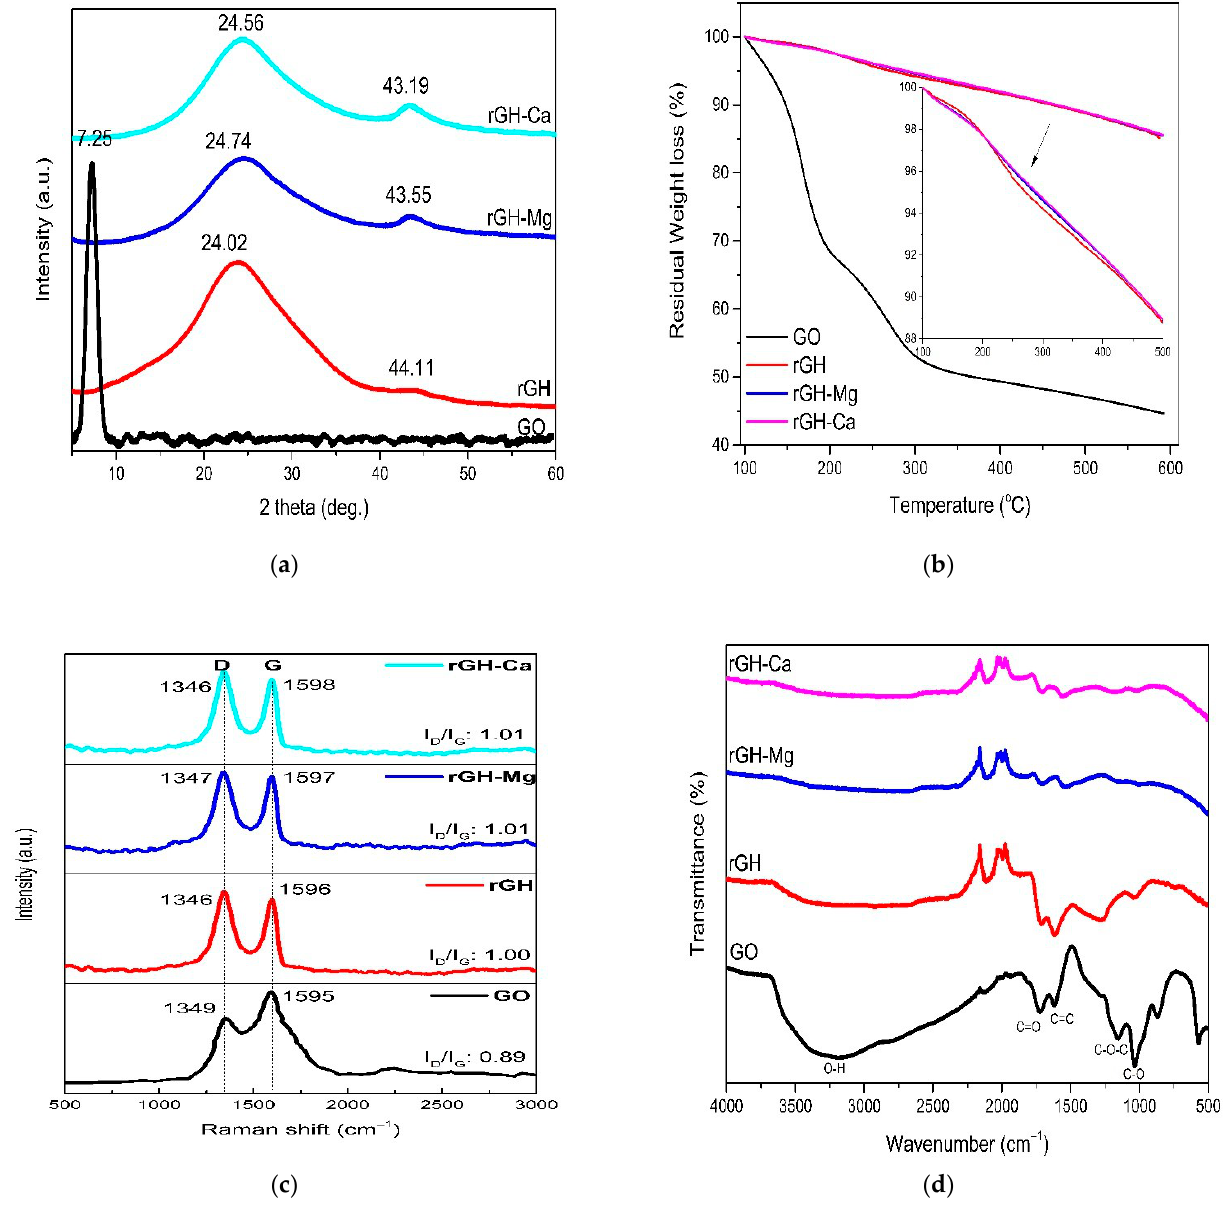
Figure 2. ( a ) X-ray diffraction (XRD) pattern, ( b ) ATR-FTIR spectra, ( c ) Raman spectra ( d ) Thermogravimetric analysis (TGA) thermogram of GO, rGH, rGH-Mg, and rGH-Ca.